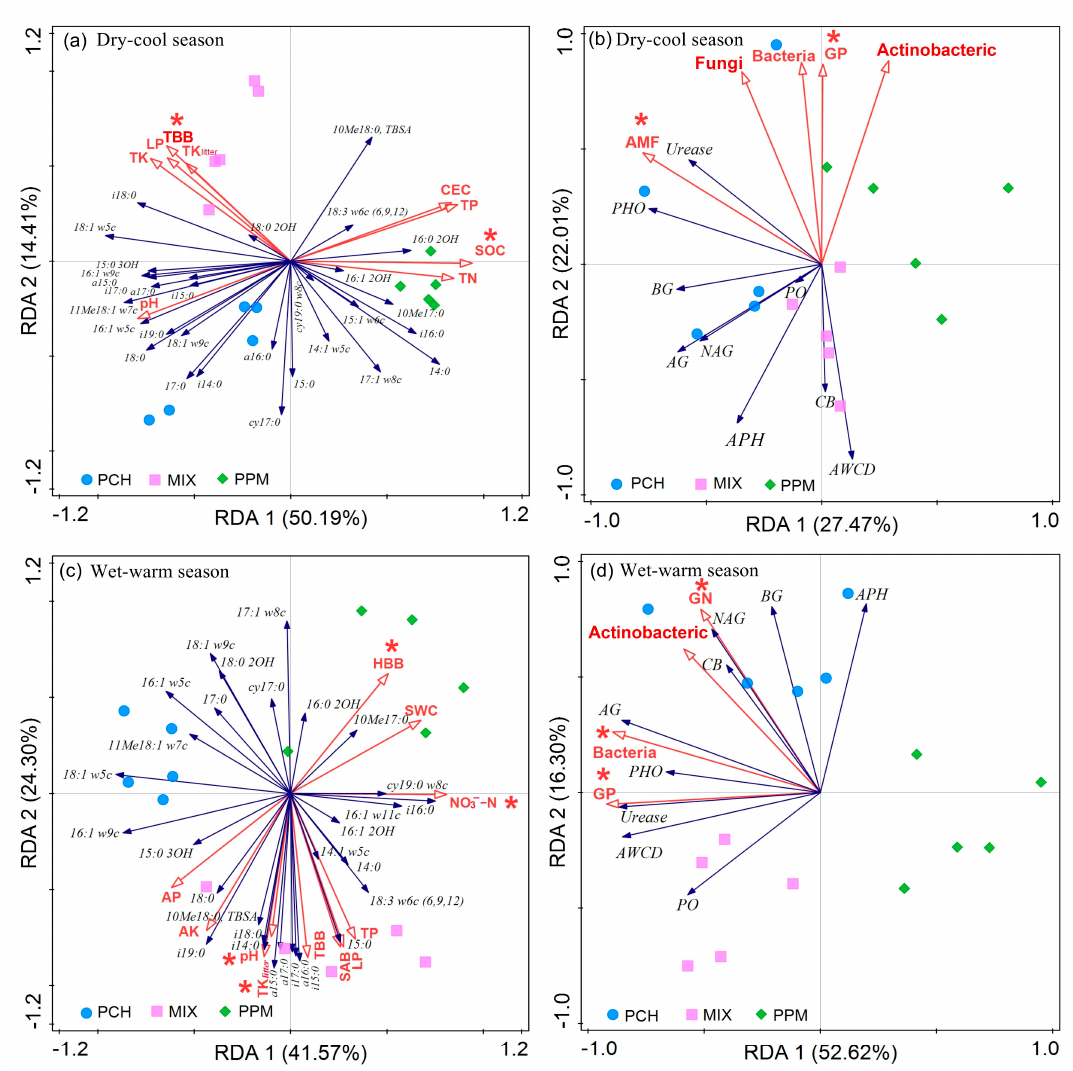
Figure 7. Redundancy analysis (RDA) ordination biplot of individual PLFAs and dominant biotic and abiotic factors in dry-cool season and wet-warm season ( a , c ). And RDA ordination biplot of soil microbial community structure and soil microbial functions ( b , d ). * Above the label represents a significant conditional effect of this factor ( p < 0.05). SOC, soil organic carbon; TBB, tree belowground biomass; TP, soil total phosphorus; TN, soil total nitrogen; CEC, soil cation exchange capacity; TK, soil total potassium; NO 3 − -N, soil nitrate nitrogen; HBB, herb belowground biomass; AP, soil available phosphorus; AK, soil available potassium; SAB, shrubs aboveground biomass; SWC, soil water content; LP, litter production; TK litter , litter total potassium; GP, gram-positive bacteria; GN, gram negative bacteria; AMF, arbuscular mycorrhizal fungi;; AG, α -Glucosidase; BG, β -1,4-glucosidase; CB, β -Cellobiosidase; APH, acid phosphatase; NAG, β -1,4-N-acetylglucosaminidase; PHO, phenol oxidase; PO, peroxidase; AWCD, average well color development of carbon source metabolism at 192 h